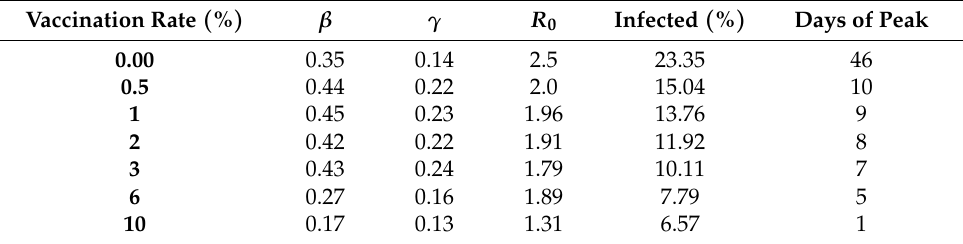
Table 3. Impact of vaccination with ( 94% ) efficacy